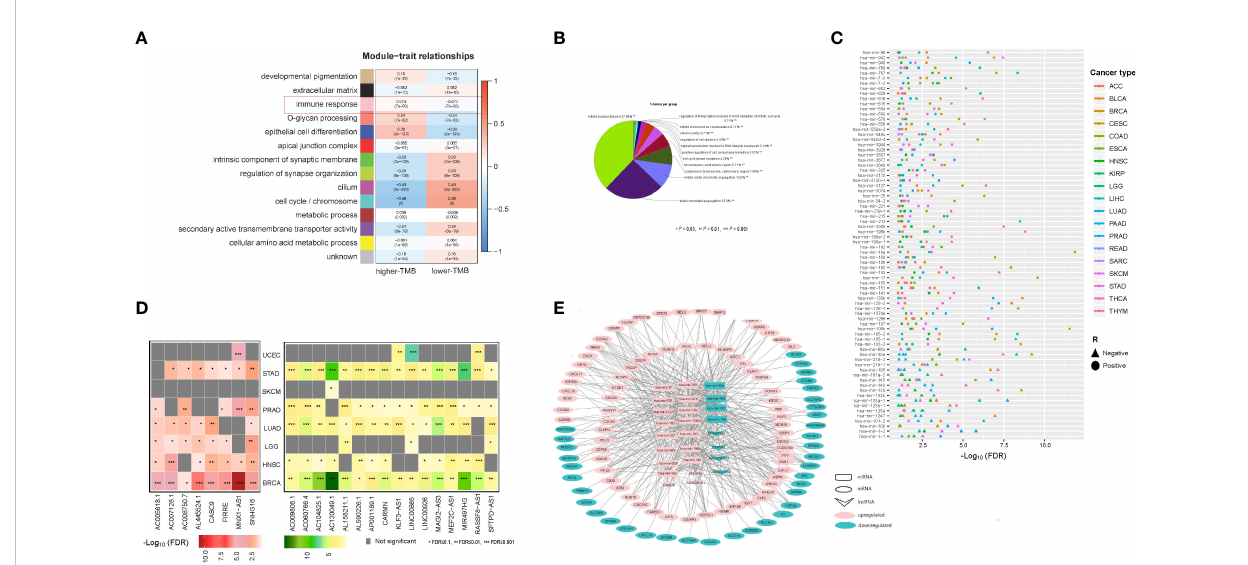
FIGURE 6 CeRNA network which constructed by mRNA, miRNAs and lncRNAs whose expression correlates with TMB in cancer. (A) WGCNA identi fi ed 14 coexpressed gene modules with softpower 7. The GO terms in the tan, black, pink, salmon, blue, red, green, greenyellow, magenta, turquoise, brown, purple, and yellow modules were mainly associated with developmental pigmentation, extracellular matrix, immune response, O-glycan processing, epithelial cell differentiation, apical junction complex, intrinsic component of synaptic membrane, regulation of synapse organization, cilium, cell cycle/chromosome, metabolic process, secondary active transmembrane transporter activity, and cellular amino acid metabolic process, respectively. (B) ClueGO mainly enriched the 107 WGCNA-DEmRNA in the mitotic nuclear division, regulation of cell division, and positive regulation of cell cycle phase transition. (C) 58 miRNAs whose expression levels were signi fi cantly higher in high-TMB cancers than in low-TMB cancers, and 18 miRNAs whose expression levels were signi fi cantly lower in high-TMB cancers than in low-TMB cancers in at least fi ve cancer types (Student ’ s t test, FDR<0.1). (D) Left, eight lncRNAs whose expression levels were signi fi cantly higher in high-TMB cancers than in low-TMB cancers; Right, 16 lncRNAs whose expression levels were signi fi cantly lower in high-TMB cancers than in low-TMB cancers in at least fi ve cancer types (Student ’ s t test, FDR<0.1). (E) CeRNA network constructed by 7 DElncRNAs, 20 DEmiRNAs, and 107